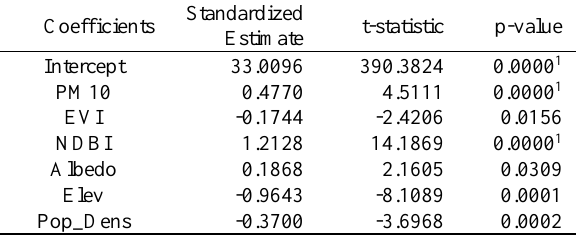
Table 8. 90 th quantile regression